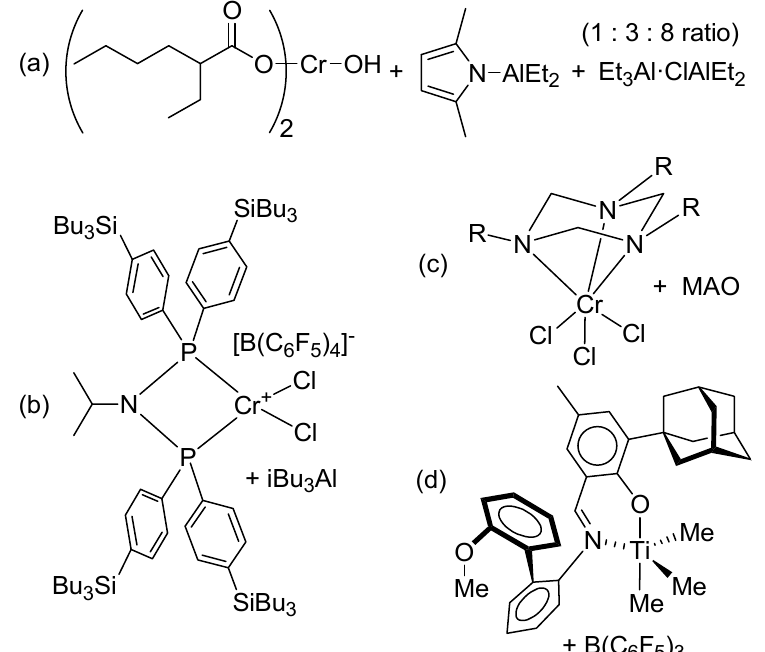
Figure 1. Ethylene or α -olefin trimerization (or tetramerization) catalysts ( a ): Phillips ethylene trimerization catalyst; ( b ): MAO-free ethylene tetramerization catalyst; ( c ) and ( d ): selective α -olefin trimerization catalyst.